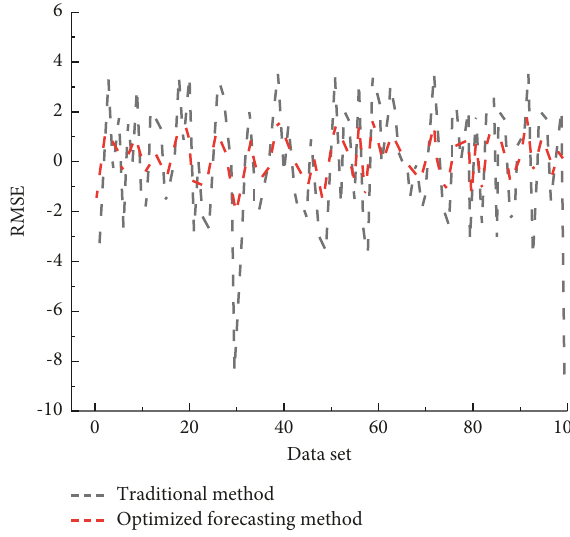
Figure 12: Comparison of root mean squared difference of the two methods.